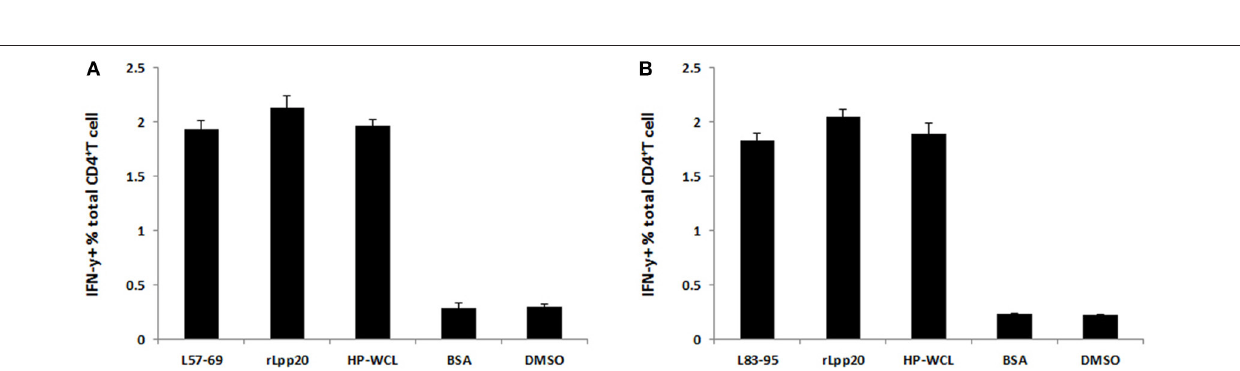
FIGURE 6 | The natural processing and presentation of L 57 – 69 and L 83 – 95 by DCs. (A) The DCs were pulsed with L 57 – 69 , rLpp20, HP-WCL, or BSA for 24h and then co-cultured with L 57 – 69 -specific T cells from subject H6 for 5h in the presence of monensin. The frequency of IFN- γ -secreting CD4 + T cells was determined by ICS. (B) L 83 – 95 -specific T cells from subject H1 were used to determine in a manner similar to the peptide described in (A) .